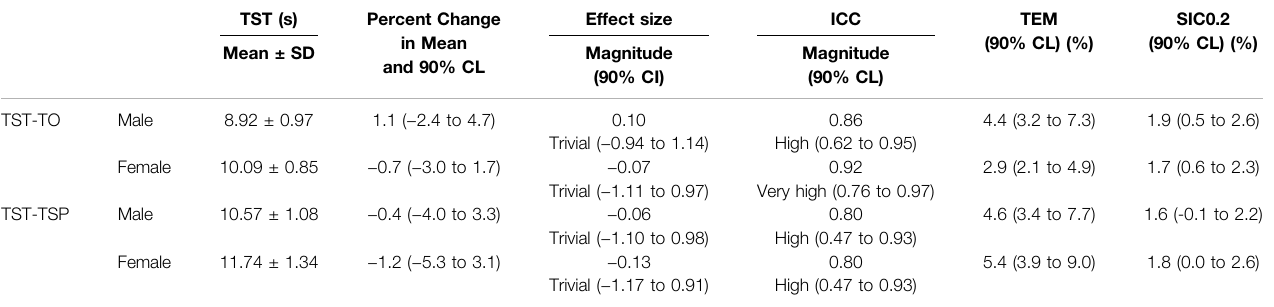
TABLE 1 | Sex-speci fi c data of taekwondo athletes (means ± standard deviations) computed with log transformed data of reliability statistics for the taekwondo speci fi c change-of-direction speed test with striking (TST) performance. TST (s)